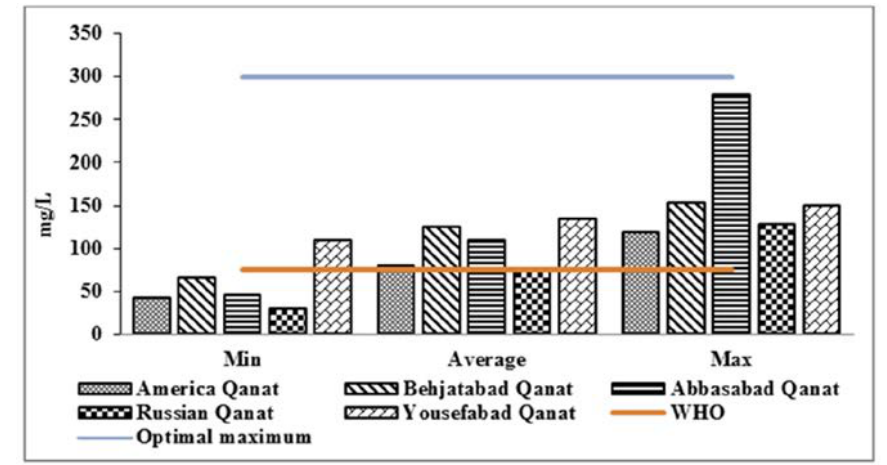
Fig. 10: Calcium level and its comparison with the WHO and the National Standard of Iran